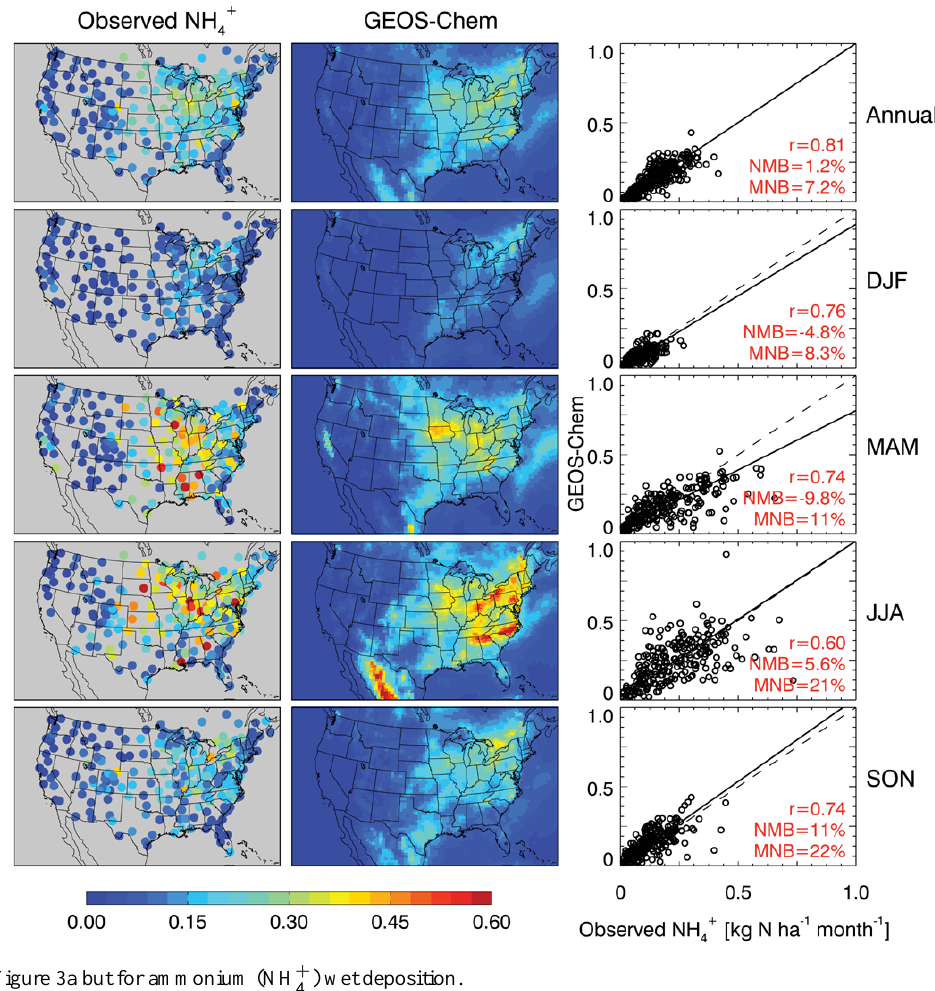
Fig. 3. Same as Figure 3a but for ammonium (NH +